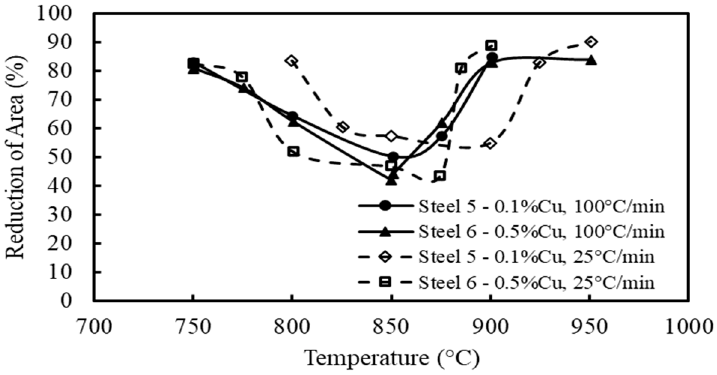
Figure 3. Hot ductility curves for low Ti (0.006%) “microalloyed” steels, steels 5 and 6 having residual Cu and ~0.5% Cu, respectively, tested at two different cooling rates, 25 K/min and 100 K/min.